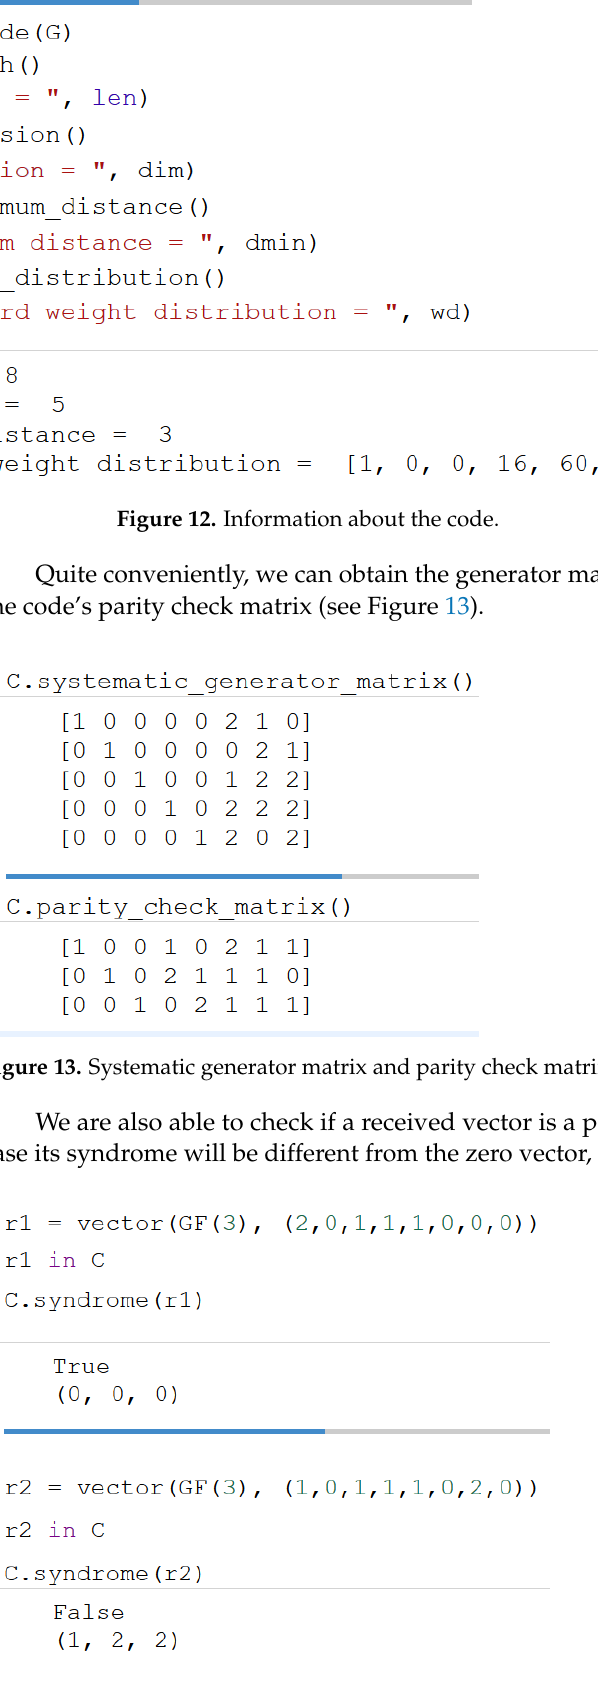
Figure 14. Checking if a received vector is a